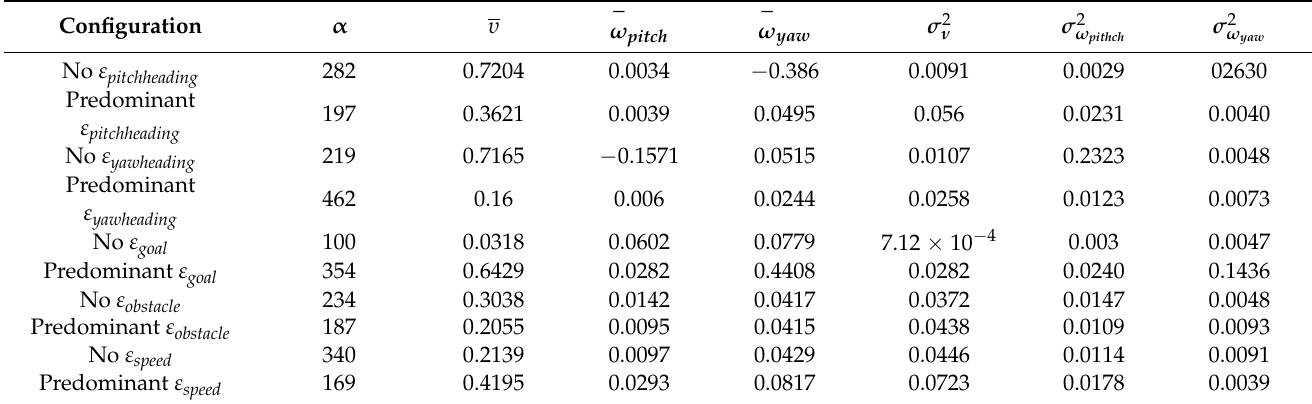
Table 1. The results of the parameter